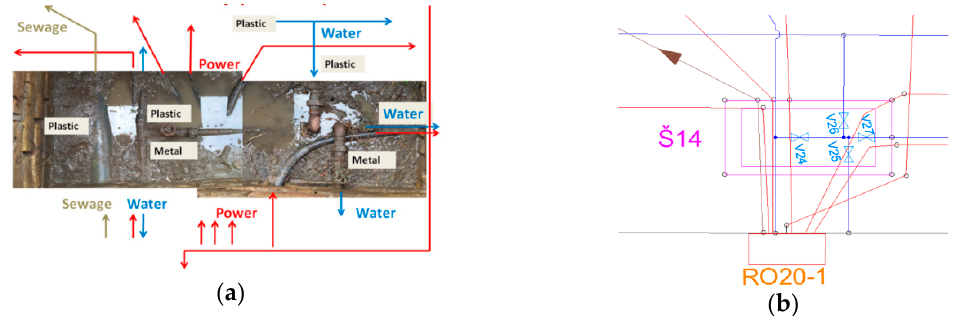
Figure 1. ( a ) A photo of a shaft in a factory; ( b ) a 2D map of the shaft in the utility network cadastre.